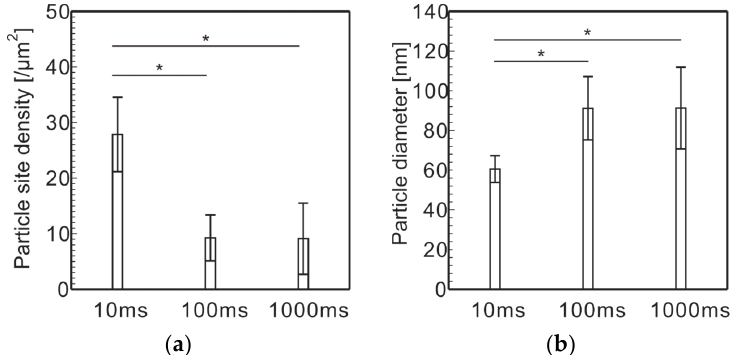
Figure 11. Measurement results of ( a ) particle site density (n = 27, mean ± S.D.) and ( b ) particle diameter (n = 45, mean ± S.D., * p < 0.05, Welch’s t test with Bonferroni correction) of P-Ni-CF plated using different ON-times ( I = 200 mA, J = 3.79 A/m 2 , t OFF = 100 ms, t = 5 s).